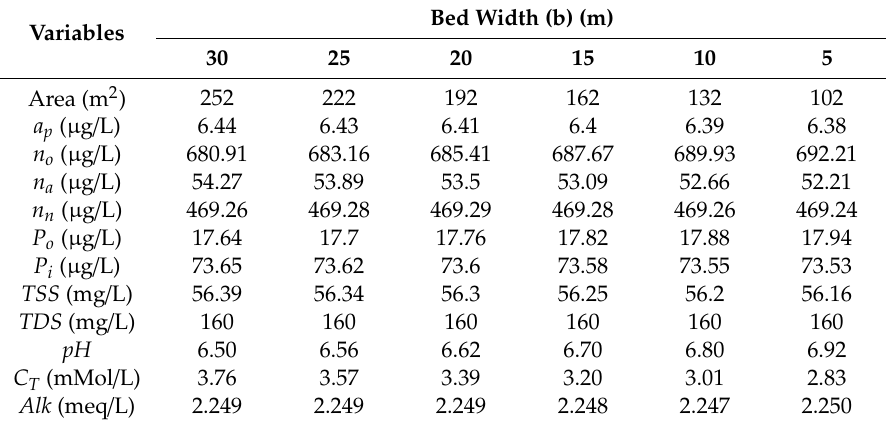
Table 11. E ff ect of bed width (b) on di ff erent water quality